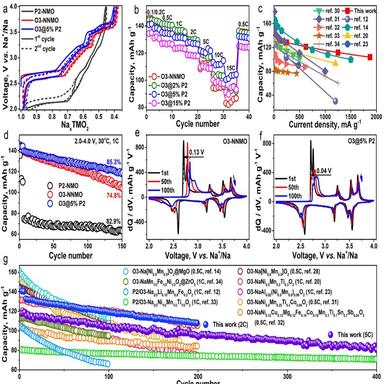
Electrochemical performances of half cells having P2-NMO, O3-NNMO, and O3@5% P2 cathodes (1 C = 125 mA h g−1). (a) Charge/discharge curves for the first two cycles of P2-NMO, O3-NNMO, and O3@5% P2. (b) Rate capabilities of half cells having various cathodes. Comparisons of the (c) rate capabilities and (g) long‐term cycle life achieved by half cells having an O3@5% P2 cathode and previously reported Mn-based cathodes. (d) Cycling stability of the prepared cathodes at 1 C. Corresponding differential capacity